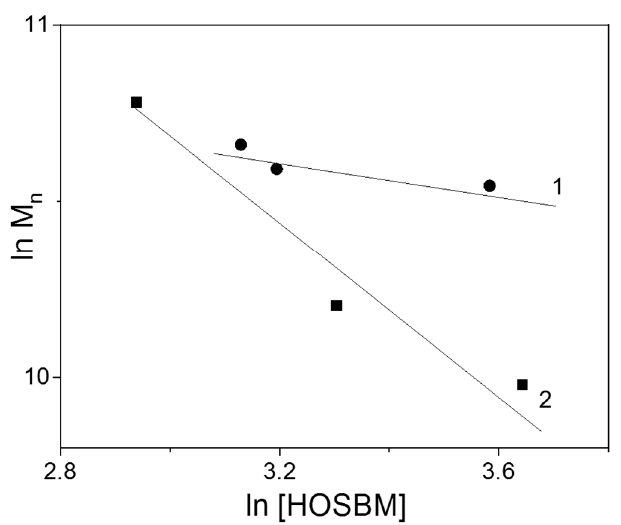
Figure 4. A log-log dependence of number average molecular weight (Mn) and HOSBM-BA-St (1)/HOSBM-BA-MMA (2) weight concentration.